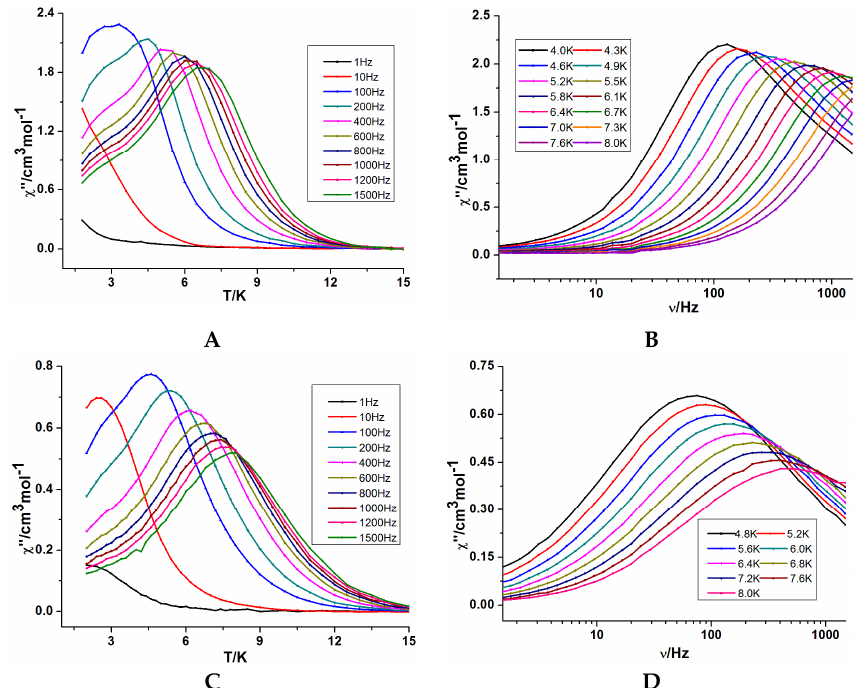
Inorganics 2016 , 4 , 2 D Figure 3. Temperature dependence ( A ) and frequency dependence ( B ) of the out-of phase ac susceptibility for 1 ( A , B ) under 2000 Oe dc field and Temperature dependence ( C ) and frequency dependence ( D ) of the out-of phase ac susceptibility for 2 ( C , D ) under zero dc field.